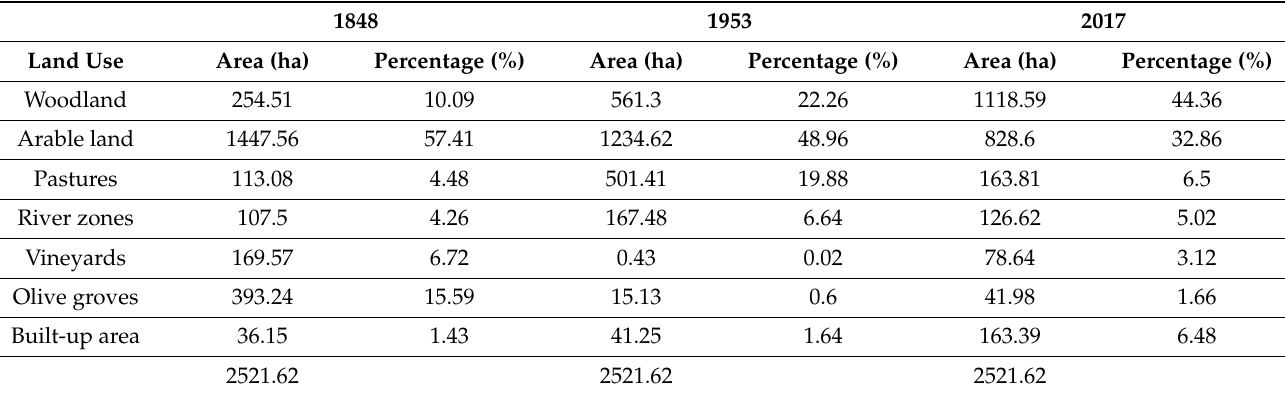
Table 1. Land-use analysis from 1848 to